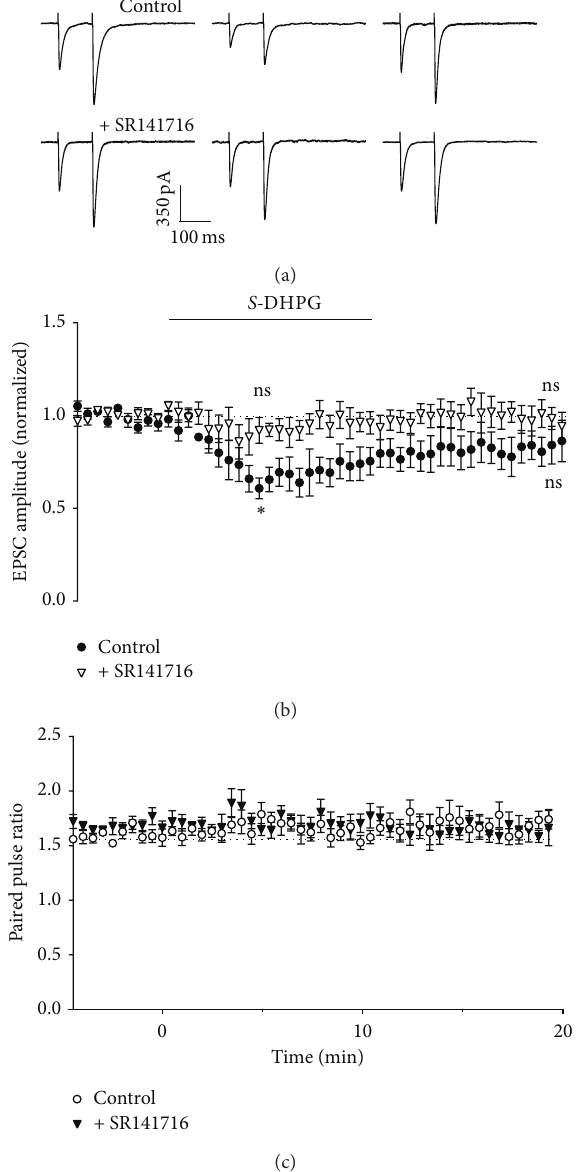
Figure 6: Effect of activation of mGluR1 on Purkinje neuron responses is blocked by antagonism of cannabinoid receptor 1. (a) Representative whole-cell recordings of EPSCs generated by paired pulse stimulation (100ms interval) of parallel fibres in transverse cerebellar slices at 0.033 Hz before (left hand panels), after 5 minutes incubation with 30 𝜇 M DHPG (centre panels), and after 10 minutes of washout (right hand panels). Recordings are shown from cells recorded in the presence of DHPG alone (upper panels) and coapplied with 5 𝜇 M SR141716 (lower panels). Cells treated with SR141716 were preincubated with this compound for 5 minutes prior to DHPG addition. (b) Time course of 30 𝜇 M DHPG effect on amplitude of the first pulse in each pair, either alone (filled circles) or with 5 𝜇 M SR141716 (open triangles), with DHPG incubation at the time indicated by the bar. Data are mean ± s.e.m. from 6 cells for each condition. ∗ 𝑃 = 0.0014 , one-sample 𝑡 -test. (c) Time course of 30 𝜇 M DHPG effect on paired pulse ratio, either alone (open circles) or with 5 𝜇 M SR141716 (filled triangles), with DHPG incubation at the time indicated by the bar. Data are mean ± s.e.m. from 6 cells for each condition.